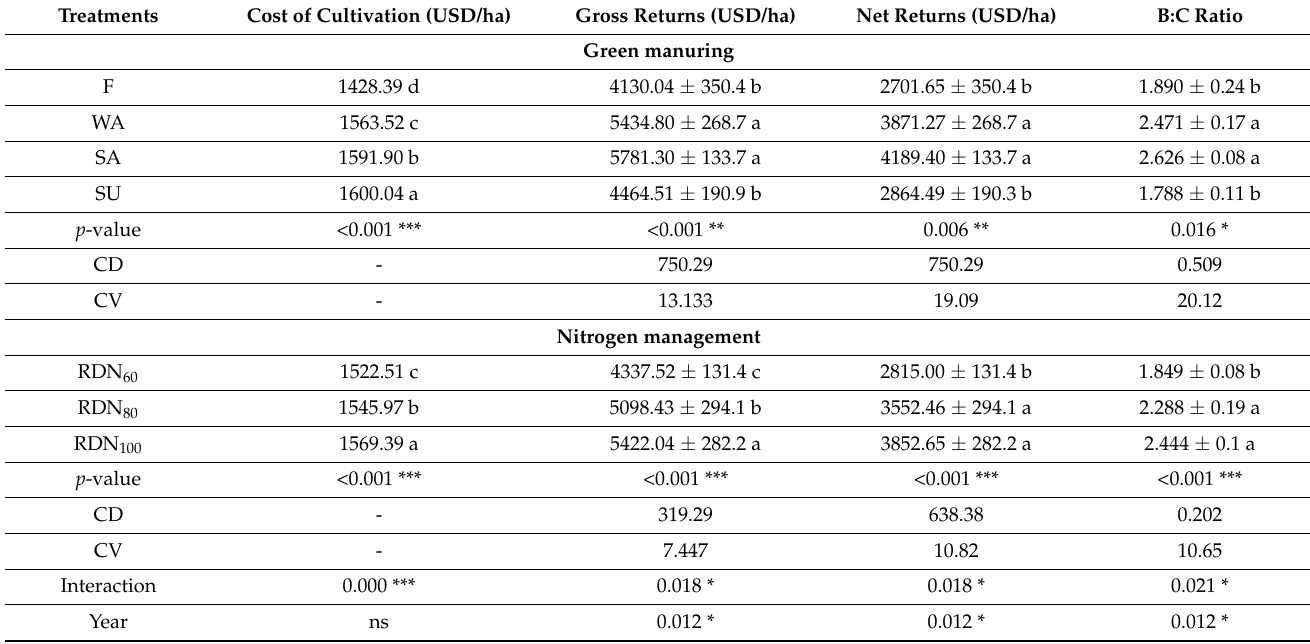
Table 5. Effect of summer green manuring and nitrogen management on economics of unpuddled transplanting of hybrid rice and baby corn cropping